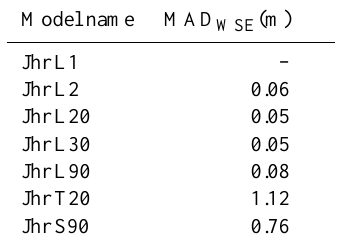
Table 6. Effects of DEMs (source and resolution) on HEC-RAS simulations.